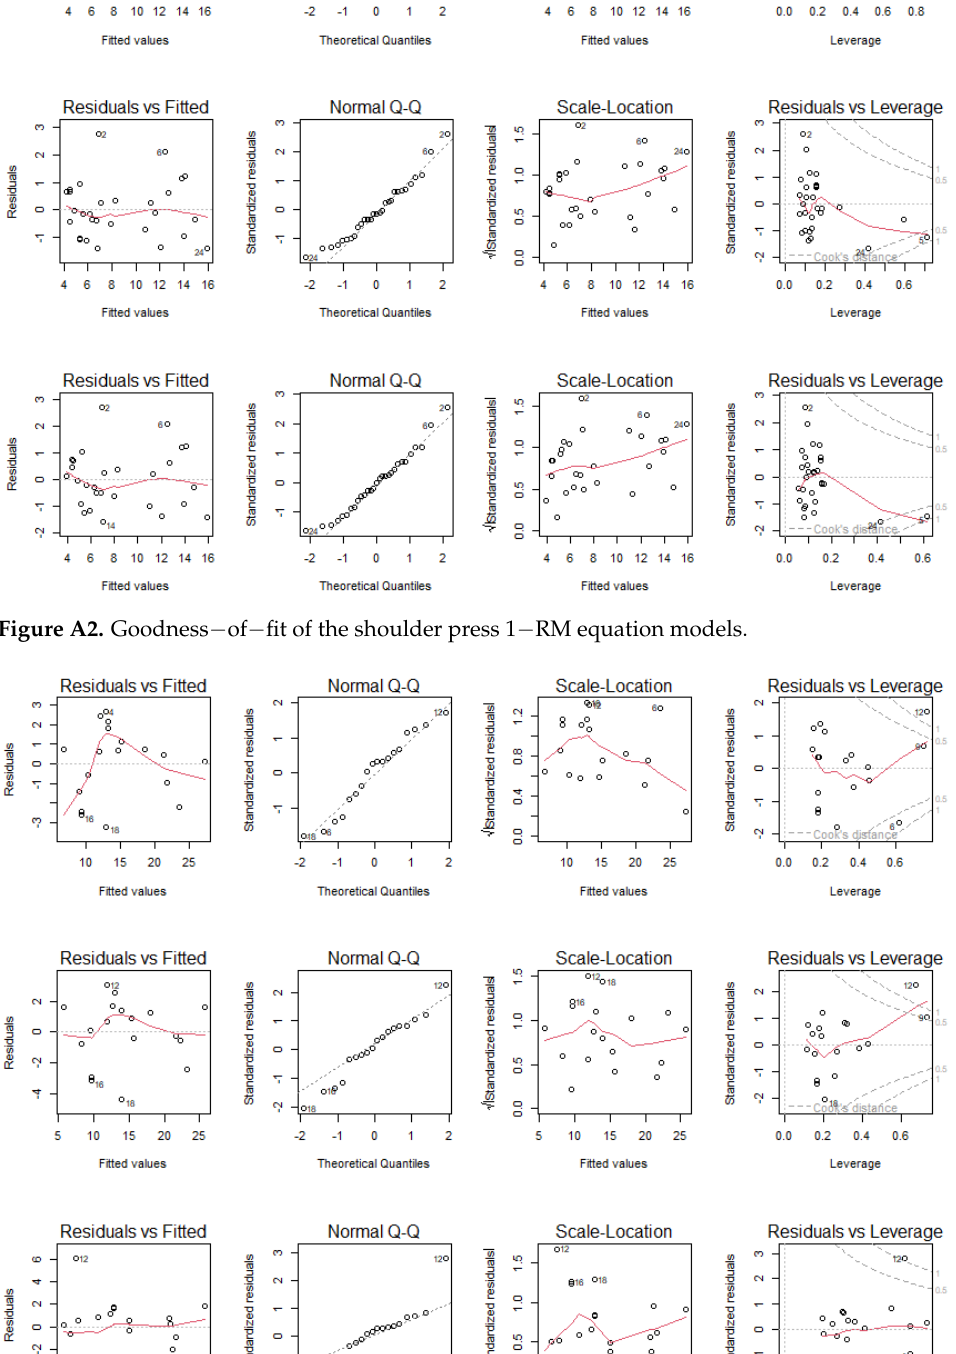
Figure A3. Goodness − of − fit of the seated row 1 − RM equation models.